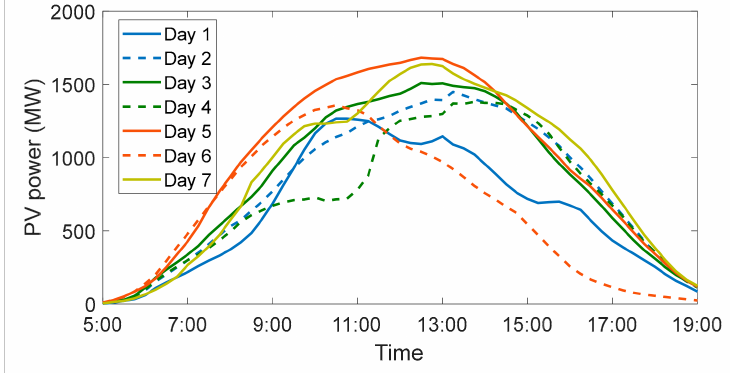
Figure 2. The PV power generation curves of adjacent days in Flanders,